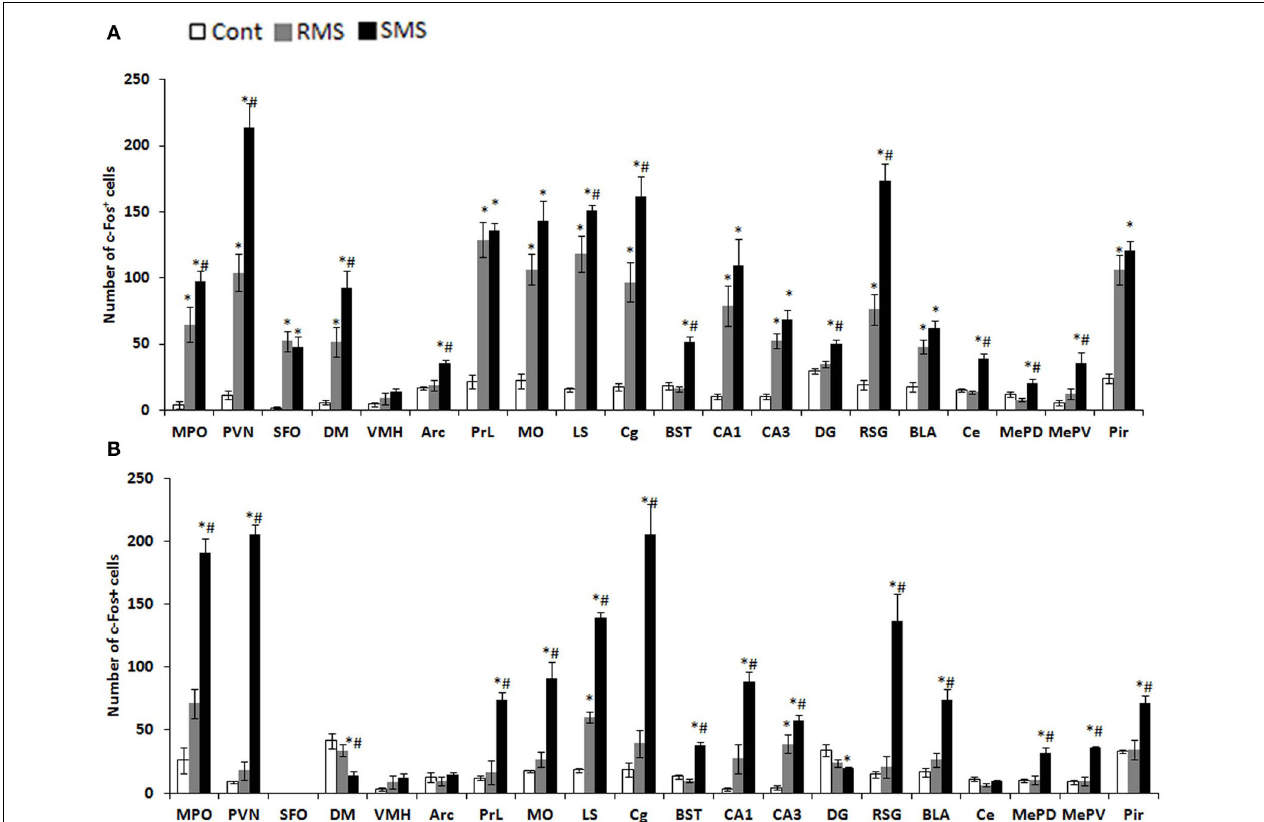
nucleus; PrL, prelimbic cortex; MO, medial orbital cortex; LS, lateral septum; Cg, cingulate cortex; BST, bed nucleus of stria terminalis; CA1, hippocampal area CA1; CA3, hippocampal area CA3; DG, dentate gyrus; RSG, retrosplenial granular cortex; La, lateral amygdaloid nucleus; BLA, anterior part of the basolateral amygdaloid nucleus; Ce, central amygdaloid nucleus; MePD, posterodorsal part of the medial amygdaloid nucleus; MePV, posteroventral part of the medial amygdaloid nucleus; Pir, piriform